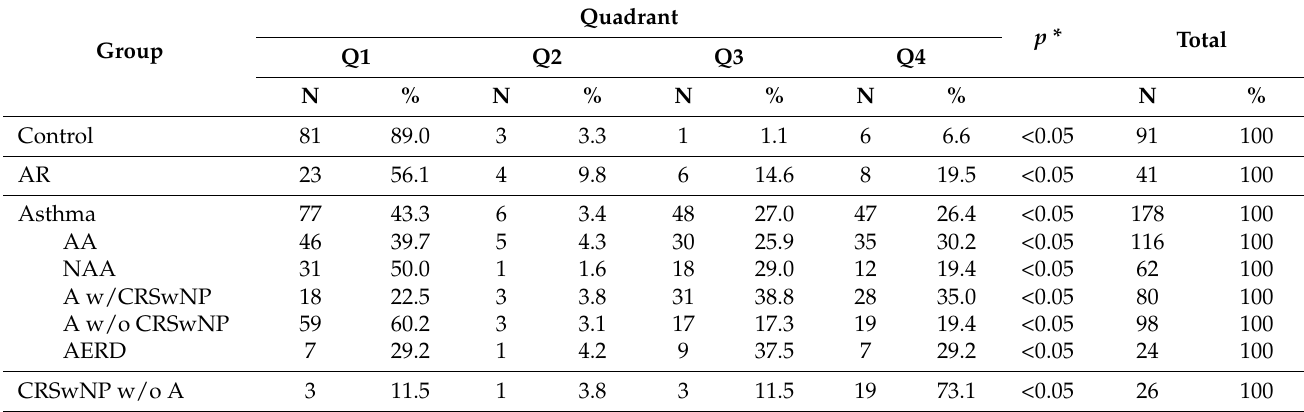
Table 9. Distribution of controls and patients among the four quadrants obtained by dividing according to values for eosinophil counts ( ≥ 250 cells/ µ L) and PTGDR2 expression in controls ( ≥ 9.3-fold difference), both with a specificity ≥ 95%.